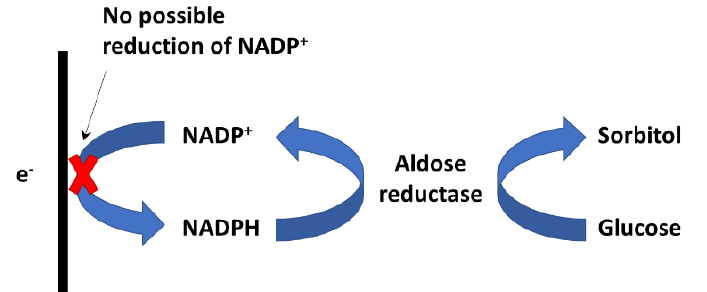
Figure 5. Schema of catalytic reduction of glucose to sorbitol by the enzyme aldehyde reductase (ALDR). Left, as is known, the NADP + reduction is not possible on the kind of electrode.